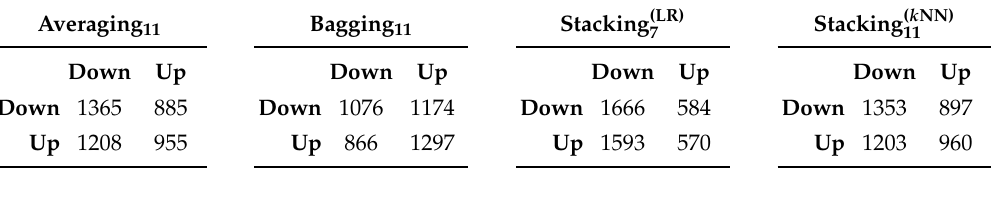
and Stacking ( k NN) using 7 11